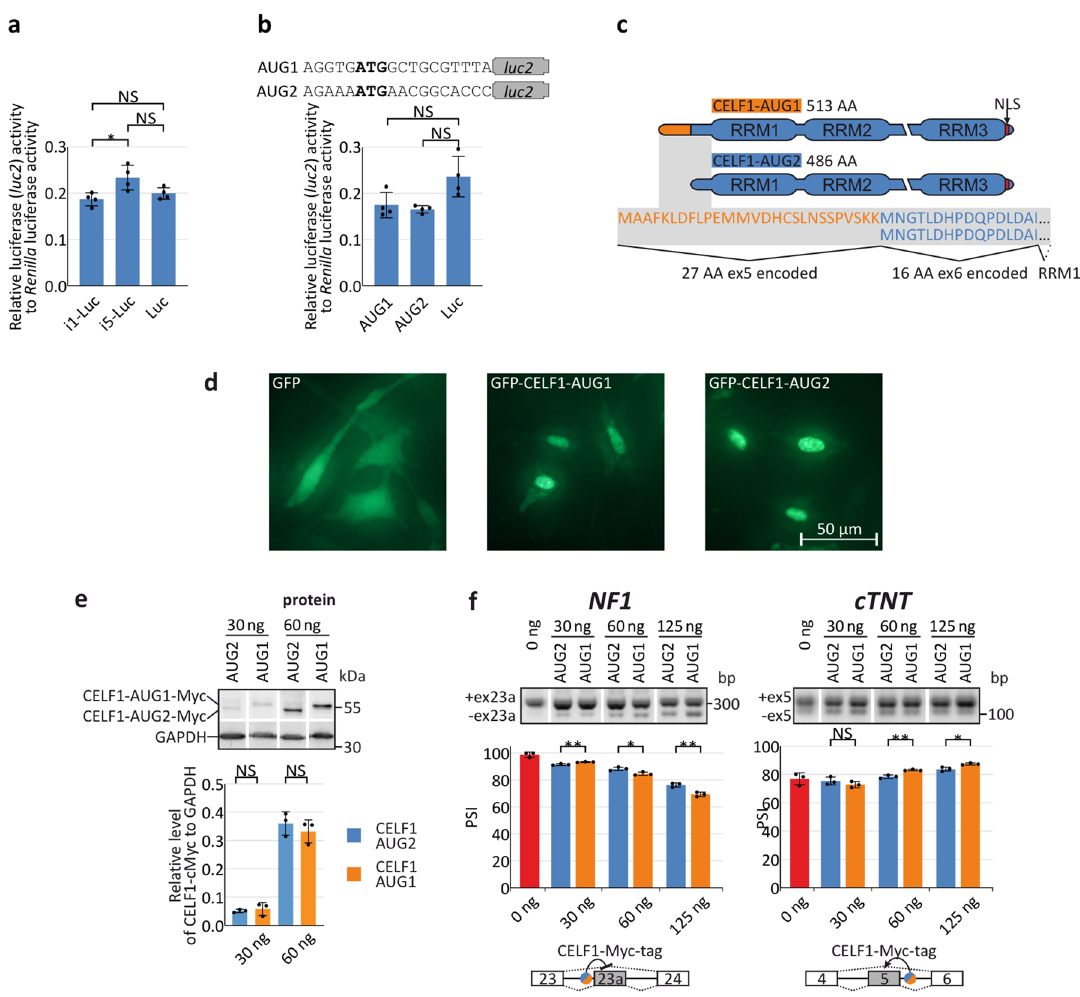
Figure 3. Impact of CELF1 5 ′ UTR isoforms on the quantity and activity of CELF1 protein. ( a ) Relative activity of luciferase 2 ( luc2 ) translated from plasmids containing i1-P1 or i5-P1 CELF1 5 ′ UTR isoforms. ( b ) Effect of AUG codon context on CELF1 translation activity. Short sequences containing two AUG codons (AUG1 and AUG2) were cloned upstream of the luc2 ORF (upper panel). Both sequences had similar translation activity (lower panel). ( c ) Two CELF1 protein isoforms differing in length in the N-terminal domain. The CELF1-AUG1 isoform is 27 AA longer than the CELF1-AUG2 isoform; their total lengths are 513 AA and 486 AA, respectively. The nuclear localization signal (NLS) is located on the C-termini of both isoforms. ( d ) The localization of GFP-CELF1-AUG1 and GFP-CELF1-AUG2 in HepG2 cells is the same. ( e ) The transfection with the same amount of plasmid encoding CELF1-AUG1 and CELF1-AUG2 results in the same quantity of translated proteins. Quantification of the level of CELF1-Myc-tag is normalized to GAPDH (COS-7 cells, n = 3). Cropped blots are presented. ( f ) Splicing activity of CELF1 isoforms. Different amounts of CELF1-AUG1 or CELF1-AUG2 expression construct were cotransfected with NF1 and cTNT splicing minigenes containing CELF-dependent alternative ex23a and ex5, respectively. The results of RT-PCR splicing assays showed that CELF1-AUG2 (the shorter isoform) had lower splicing activity than CELF1-AUG1 (COS-7 cells, n = 3 biological replicates). The lower panels show the CELF1 binding site in intronic region of regulated minigenes. Cropped gels are presented. Statistical significance was calculated with unpaired, two-tailed t test ( NS non-significant; * P < 0.05; ** P < 0.01 and *** P <